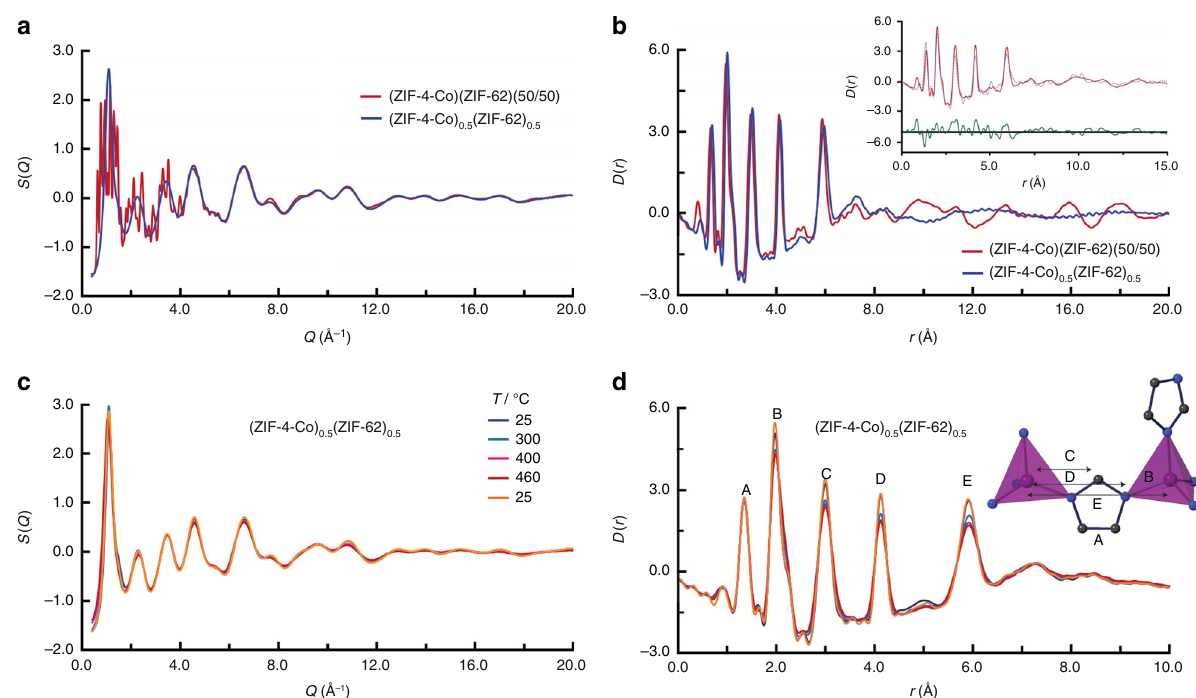
Fig. 3 Intra-domain structure. a X-ray structure factors S x ( Q ) of (ZIF-4-Co)(ZIF-62)(50/50) and (ZIF-4-Co) 0.5 (ZIF-62) 0.5 . b Corresponding X-ray pair distribution functions, D ( r ). Inset: re fi nement of (ZIF-4-Co)(ZIF-62)(50/50) against the published structure fi les for ZIF-62 and ZIF-4-Co. Fit — broken blue line. c X-ray structure factors of (ZIF-4-Co) 0.5 (ZIF-62) 0.5 upon heating. d Pair distribution functions D ( r ) of (ZIF-4-Co) 0.5 (ZIF-62) 0.5 upon heating, with the atom pairs that contribute most of the intensity in the labelled peaks indicated in the structural fragment (A –